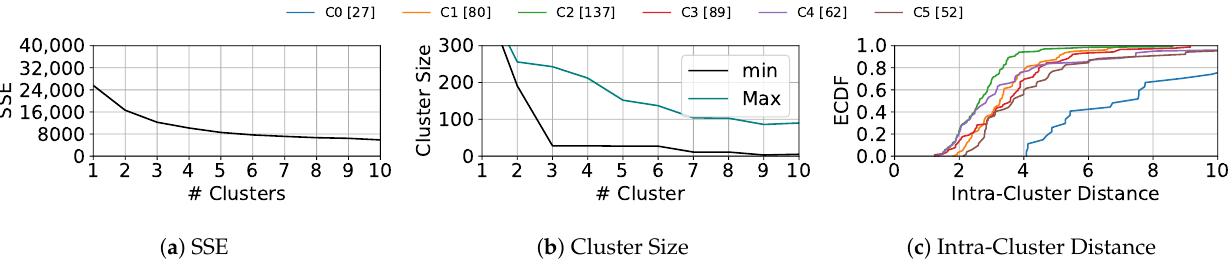
Figure 16. Cluster Metrics wp Working Station 2 Clamp 1, Steady-State aligned Data